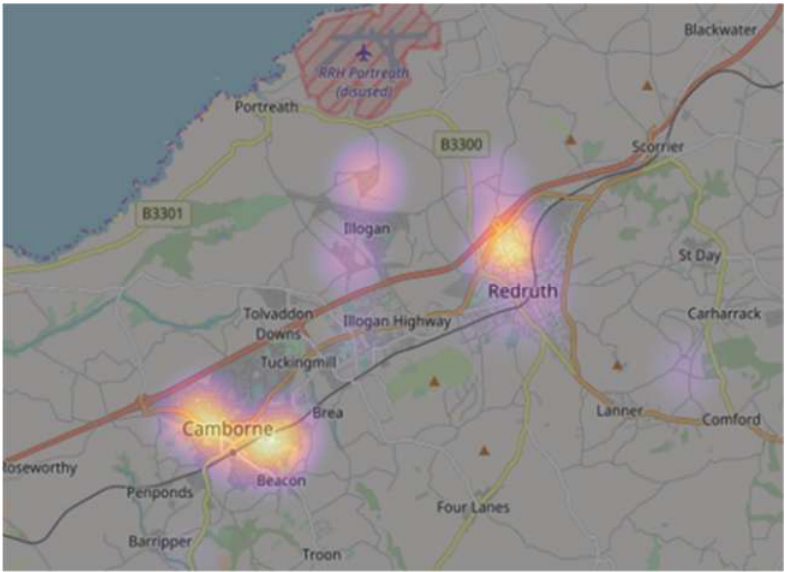
Figure 1. Map of Smartline sample residential locations.